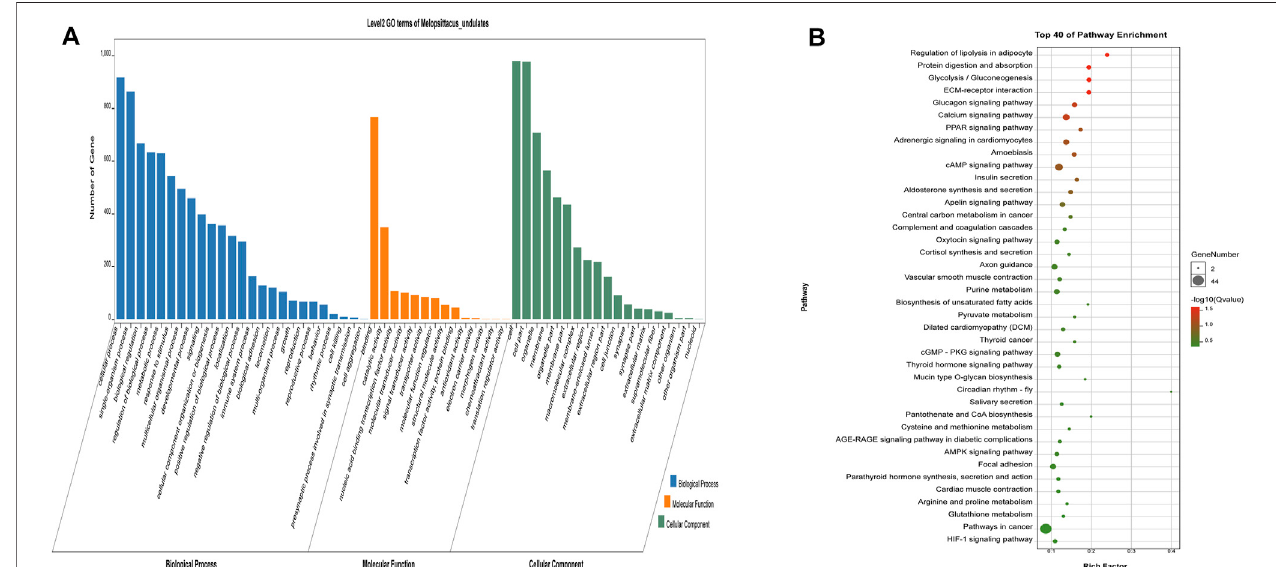
FIGURE5| Analysisresults ofpotentialtarget genesGO (A) and KEGG (B) ofLncRNA differentially expressed inbeef cattlemuscle growth and development. The legend is the same as Figure 3